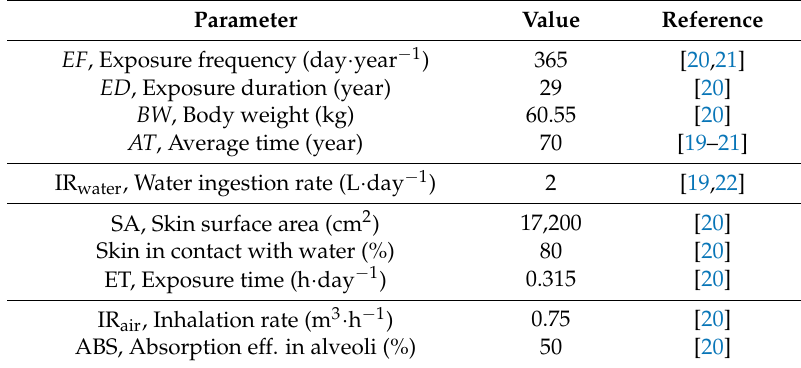
Table 1. Input parameters to determine the exposure of THM s through the three pathways.